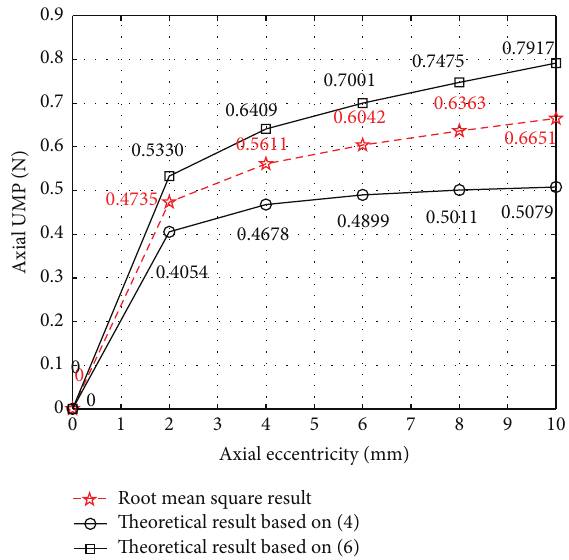
Figure 6: Relationship between AAGE and UMP based on RMS